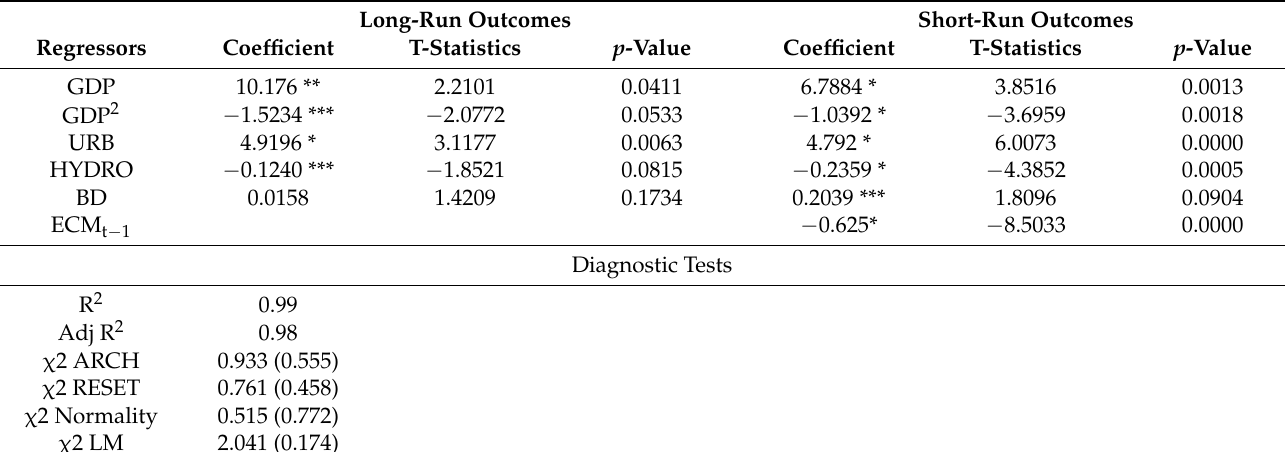
Table 3. ARDL long- and short-run outcomes.